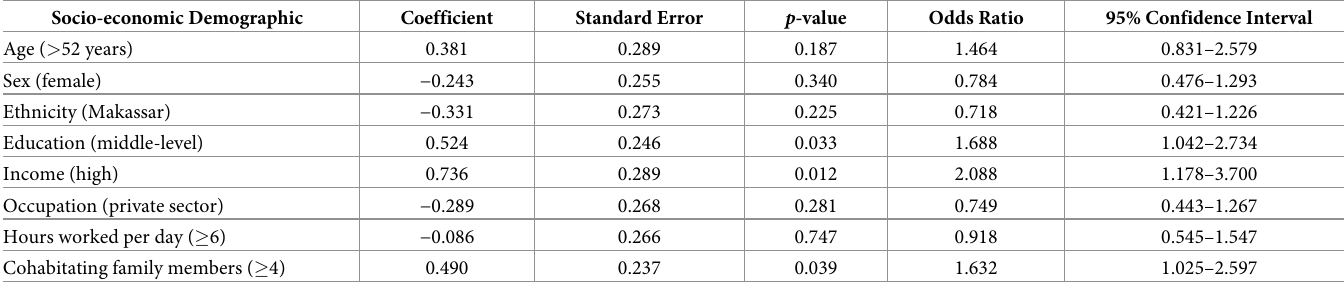
Table 6. Multiple logistic regression analysis of socio-economic-demographic determinants related to depression. Socio-economic